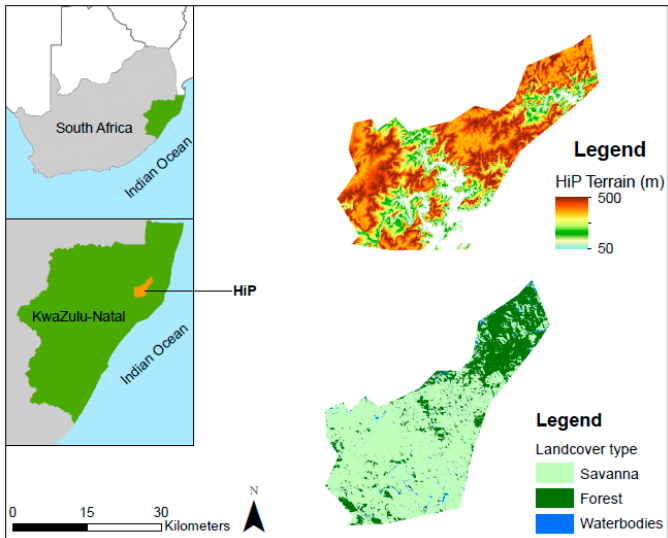
Figure 1. The study area showing the Hluhluwe-iMfolozi Park in the north-eastern part of South